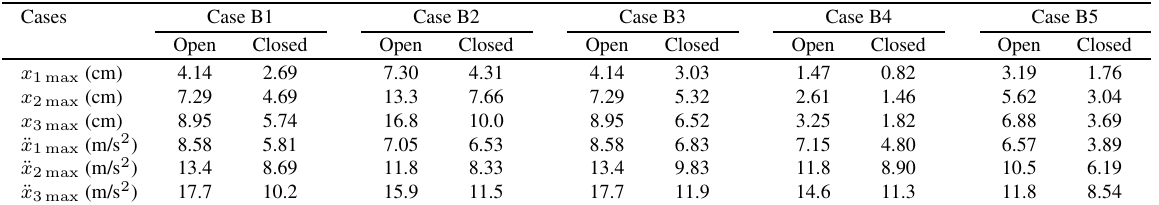
Table 3 The maximum responses of the displacements and accelerations ( τ = 25